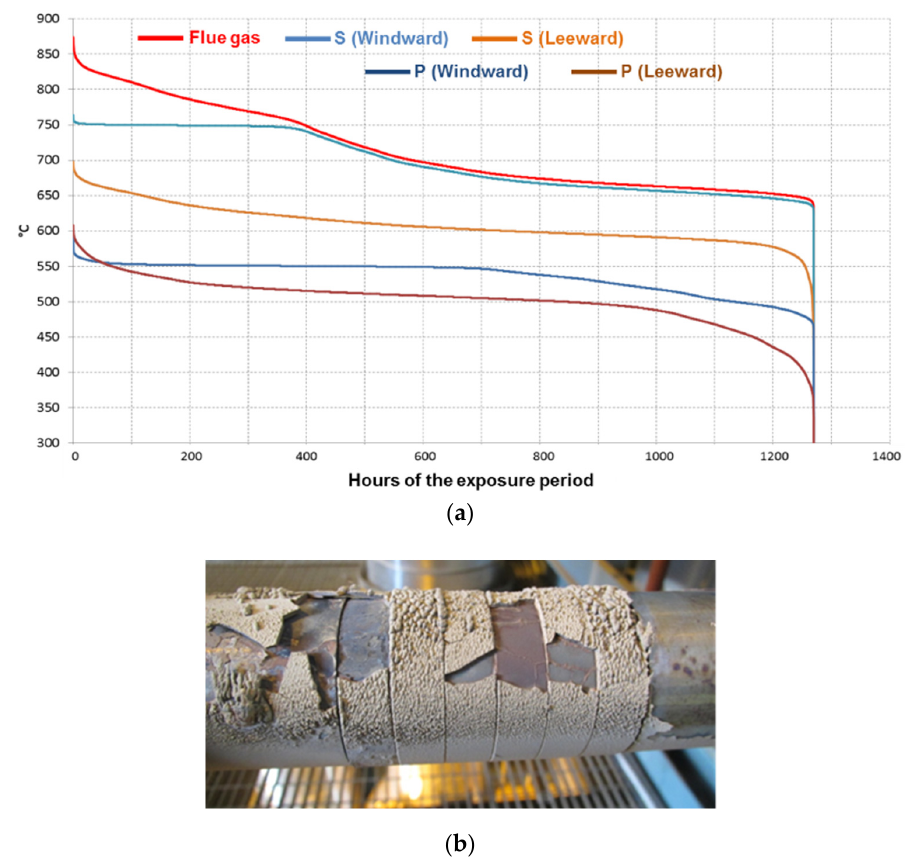
Figure 4. ( a ) Probe measurement data presented in the form of stability curve for flue gas, windward and leeward temperatures ( ◦ C) (S = secondary head, P = primary head); ( b ) Probe after the 1300 h exposure, material samples at metal temperatures of approximately 550 C.